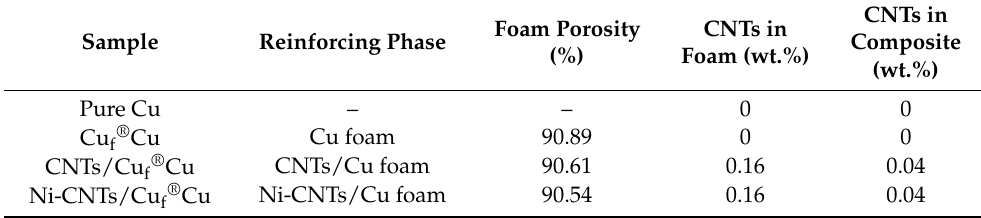
Figure 1. SA schematic illustration of the preparation process of the Ni-CNTs/Cu f® Cu composite. Table 1. The sample names and related parameters. For comparison, pure Cu, the Cu foam-reinforced Cu matrix composite (abbreviated as Cu f® Cu), and the CNTs/Cu foam-reinforced Cu matrix composite (abbreviated as CNTs/Cu f® Cu) were prepared with the same sintering parameters. The specific sample names and related parameters are shown in Table 1.